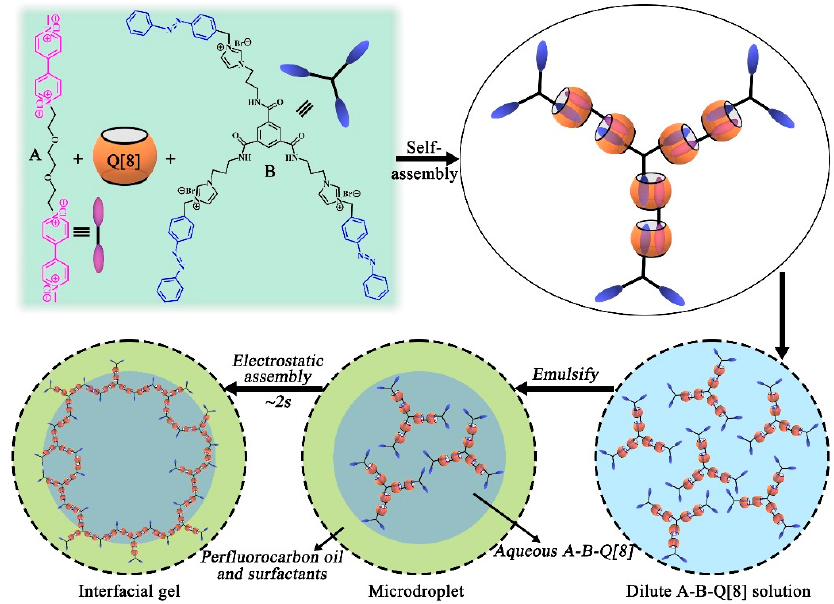
Figure 7. The preparation of the supramolecular hydrogel by Q[8] and double-guest small molecules through the host–guest inclusion interaction.